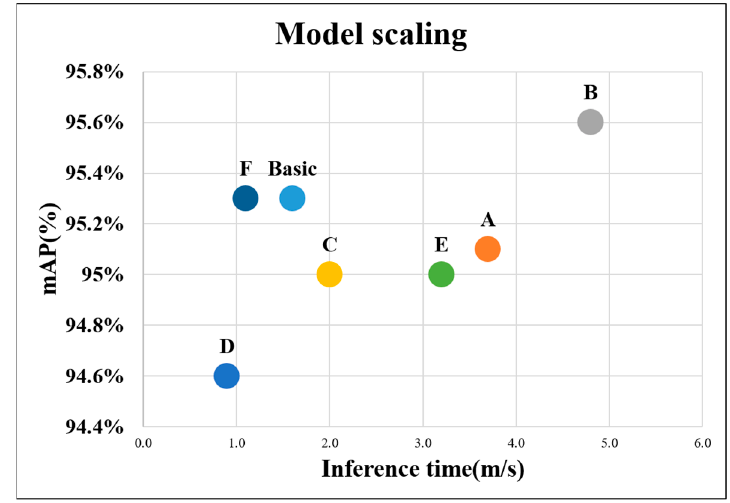
Figure 15. Result graph (model scaling).